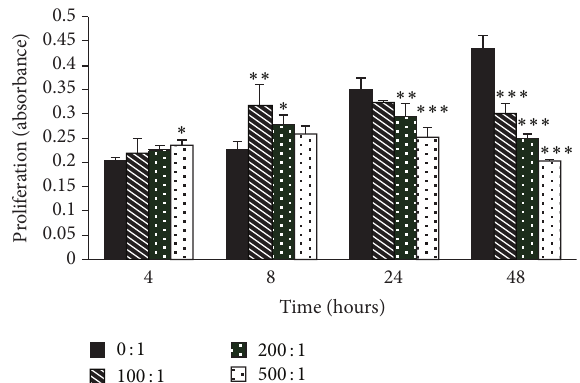
Figure 1: The effects of H. pylori on the proliferation of gastric epithelial cells. AGS cells were grown alone or with H. pylori (bacterium/cell ratio from 100: 1 to 500 :1) for 4, 8, 24, and 48 h. The proliferation of AGS cells was measured by an MTT assay. The results are expressed as absorbance at 490nm. The data are shown as means ± SD ( ∗ 𝑃 < 0.05 , ∗∗ 𝑃 < 0.01 , and ∗∗∗ 𝑃 < 0.001 when compared with different groups,